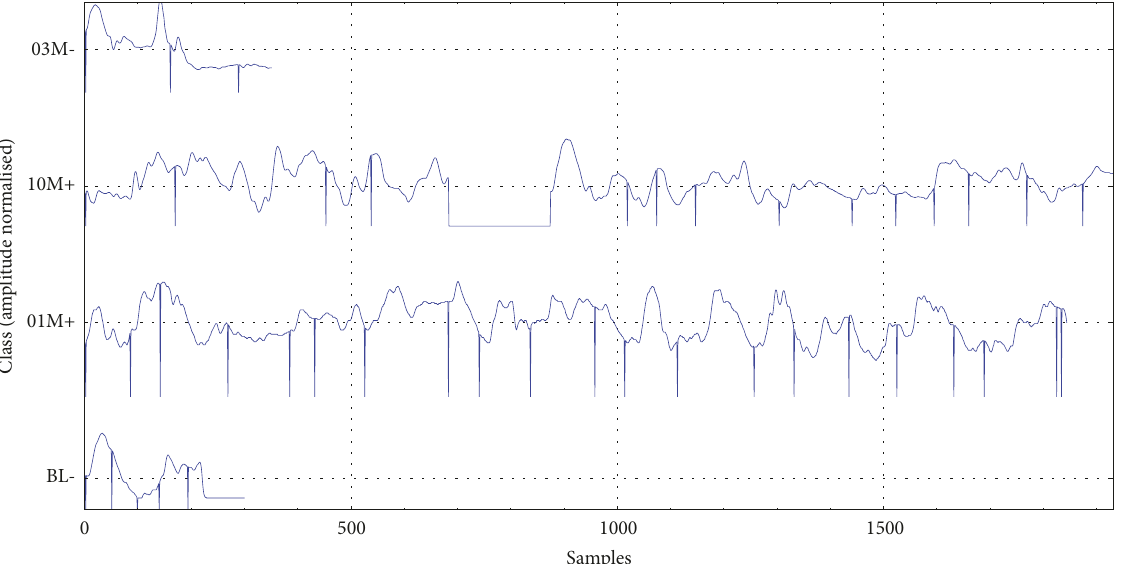
Figure 1: Example of raw glycaemia records from the database. Records corresponding to baseline, 1 month, 10 months, and 3 months after DJBL removal, are depicted. Sampling frequency was 5 minutes. Missing values were quite frequent (glucose readings spike down to 0 in the plots). Records like those shown here representing 03M- and BL- classes will be omitted in the experiments due to their short length.